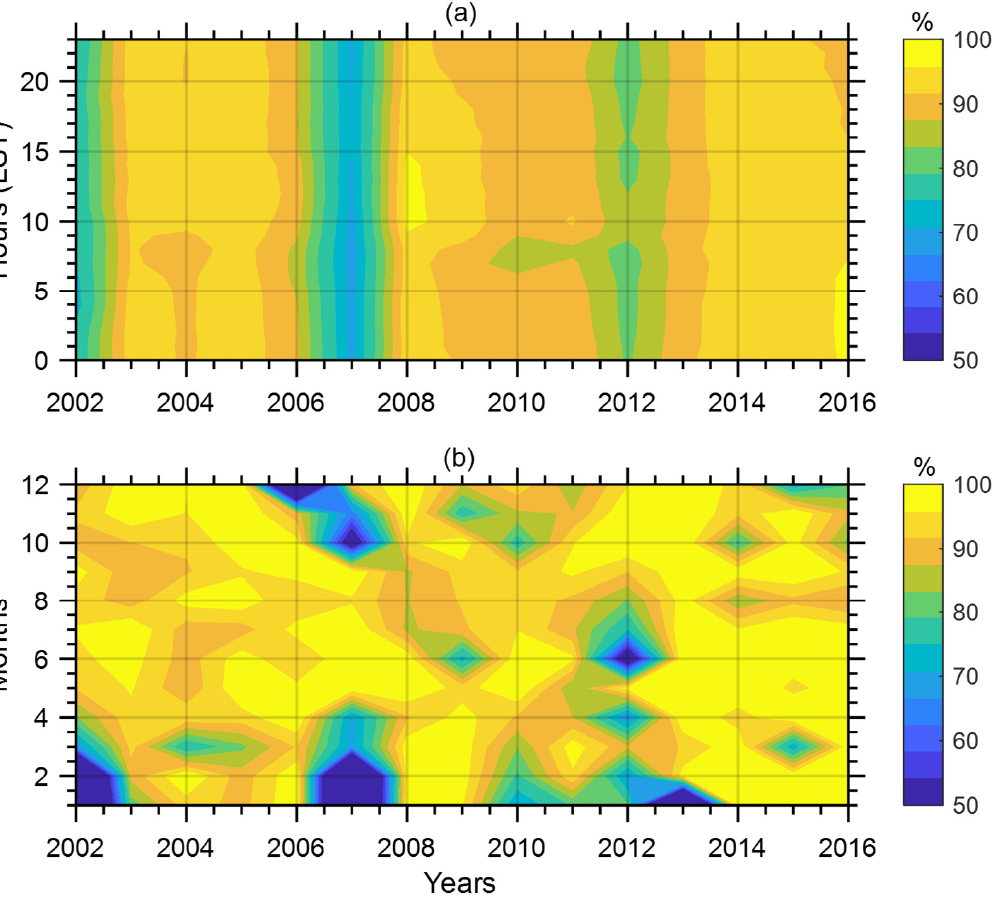
Figure 2. Availability of the data on an hourly ( a ) and monthly ( b ) basis. The percentage indicates the ratio of hourly (monthly) recorded samples to the total number of samples that would have been recorded had no measurement failures occurred during a given year.